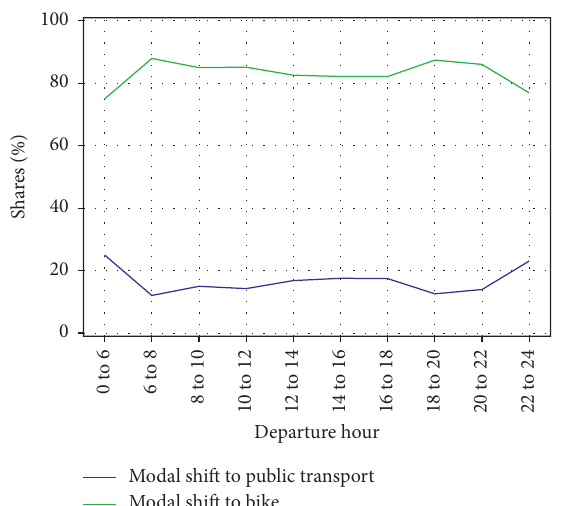
Figure 13: Share of each group of low-carbon modes in potential time-relevant modal shift from car during the